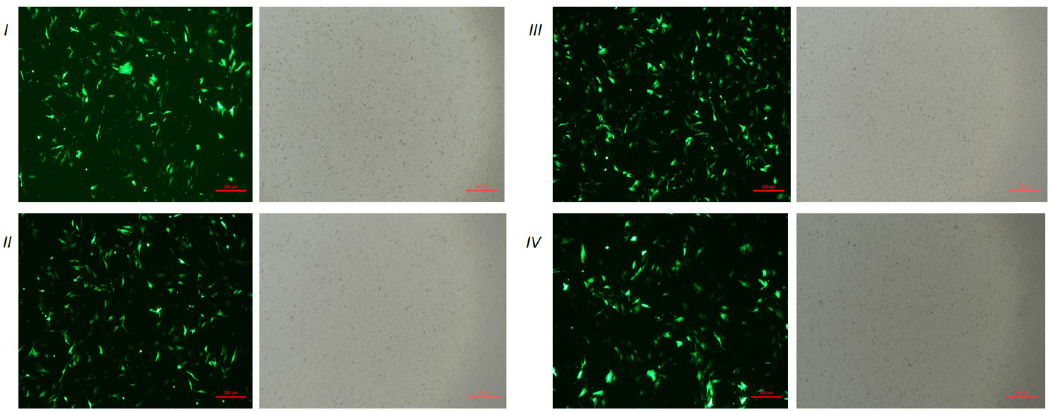
Figure 3. Expression of green fluorescence protein was observed in two vector groups under fluorescent microscopy. I: Cells transfected with pGPU6‐shDLK1 vectors, II: Cells transfected with pGPU6/GFP/Neo vectors, III: Cells transfected with pBI‐CMV3‐DLK1, IV: Cells transfected with pBI‐ CMV3 vectors.